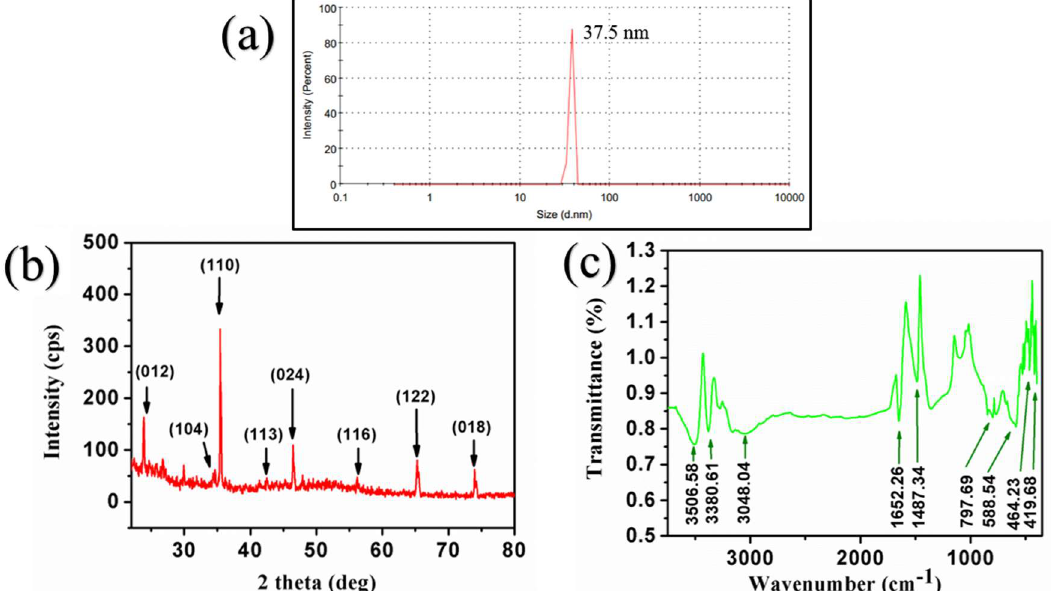
Figure 1. ( a ) Particle size distribution ( b ) XRD and ( c ) FTIR pattern of the hematite particles synthesized. Table 2. ICP-MS analysis of hematite nanoparticles.